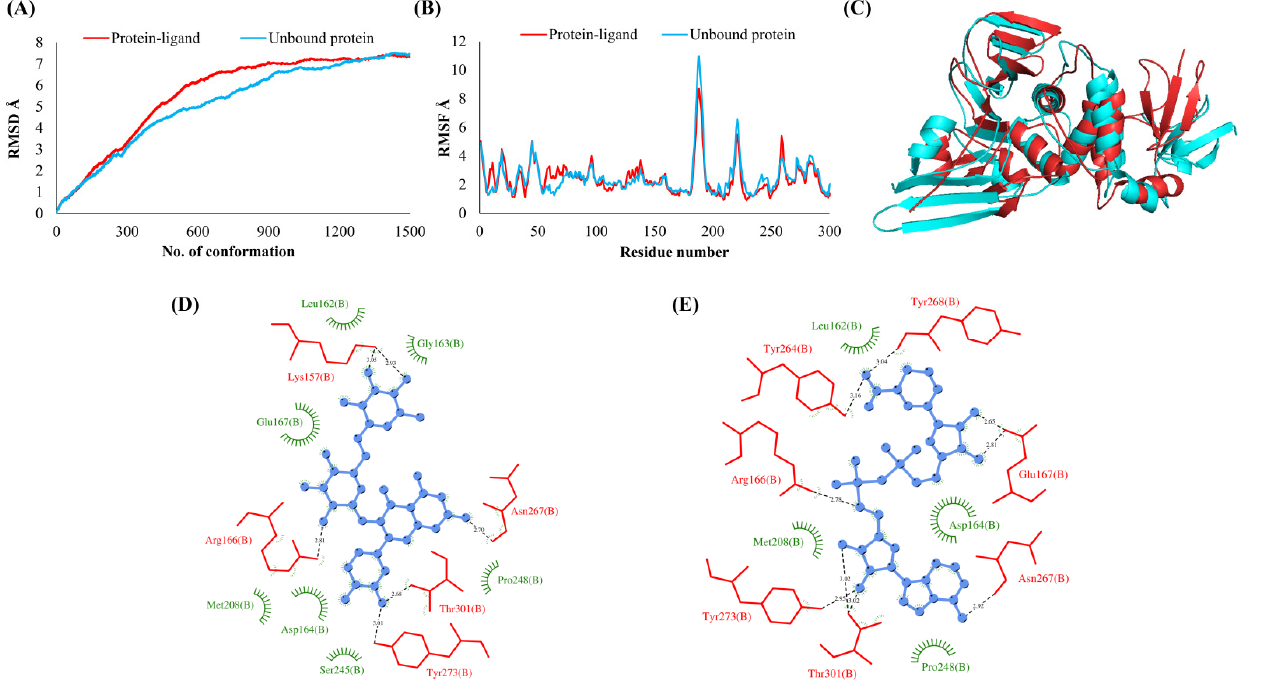
Figure 2. Papain-like protease (NSP3). ( A ) RMSD plot of unbound and ligand-bound protein ( B ) RMSF plot of unbound and ligand-bound protein ( C ) Superimposition of unbound and ligand-bound protein ( D ) Molecular interactions of protein with Rutin ( E ) Molecular interactions of protein with NADH.